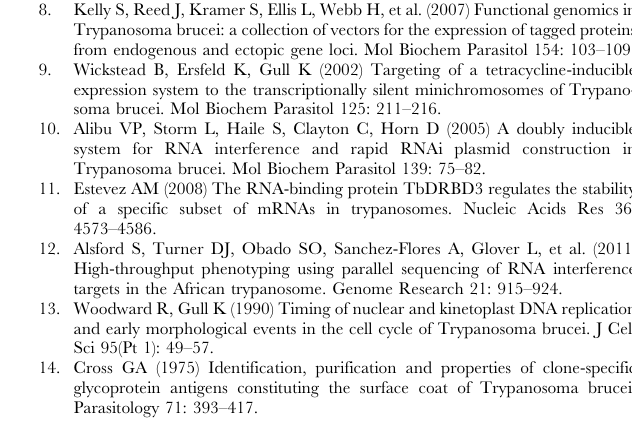
Figure S1 Expression of eYFP-NLS decreases as the space between the promoters increases. Western blot probed with anti-GFP. The levels of eYFP-NLS expression were normalised against the BiP loading control. Two independent clones of each plasmid were examined and the percentage of cells fluorescent after induction is shown. Figure S2 Flow cytometry analysis of Lister 427 pSPR2.1 p3227 and Lister 427 p3383. Two independent clones of each cell line were analysed with the typical result presented here. Red line untransformed Lister 427 pSPR2.1, black line uninduced, green line 18 hours tet induction. Table S1 Table describing inducible tagging plasmids produced.